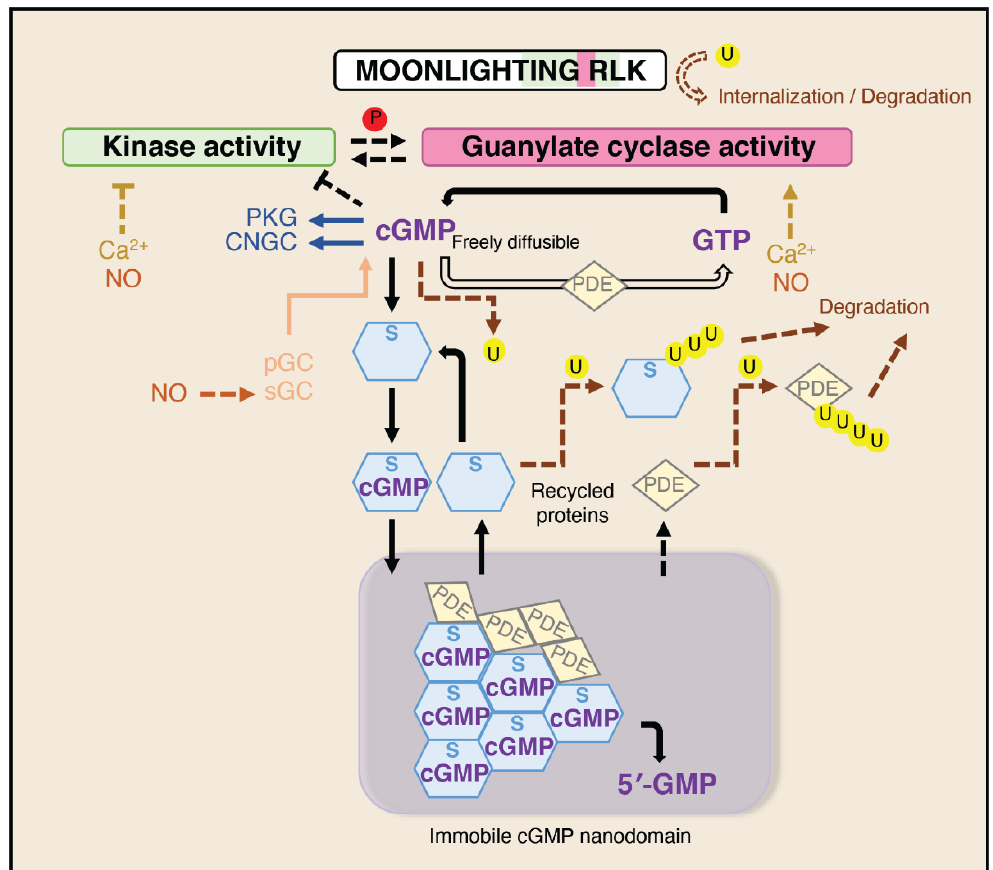
Figure 3. Schematic showing generation of cGMP by a moonlighting receptor like kinase (RLK) and the associated protein complex enabling cGMP enrichment due to a combination of phase condensation of proteins with disordered states and proteins with cGMP binding sites that occurs in the nanodomain surrounding the RLK complex. cGMP—3′,5′-cyclic guanosine monophosphate; GTP—guanosine-5′-triphosphate; 5′-GMP—guanosine 5′-monophosphate; Ca 2+ —calcium; CNGC—cyclic nucleotide gated channel; NO—nitric oxide; PDE—cyclic nucleotide phosphodiesterase; PKG—protein kinase G/cGMP-dependent protein kinase; S—scaffold protein. The letter P in circle indicates phosphate group, while letter U indicates ubiquitin. Arrows indicate positive regulation, while blunt-ends indicate inhibition. Regular lines indicate experimentally confirmed processes, while dashed lines indicate hypothetical actions and processes relating to a subset of the molecules.